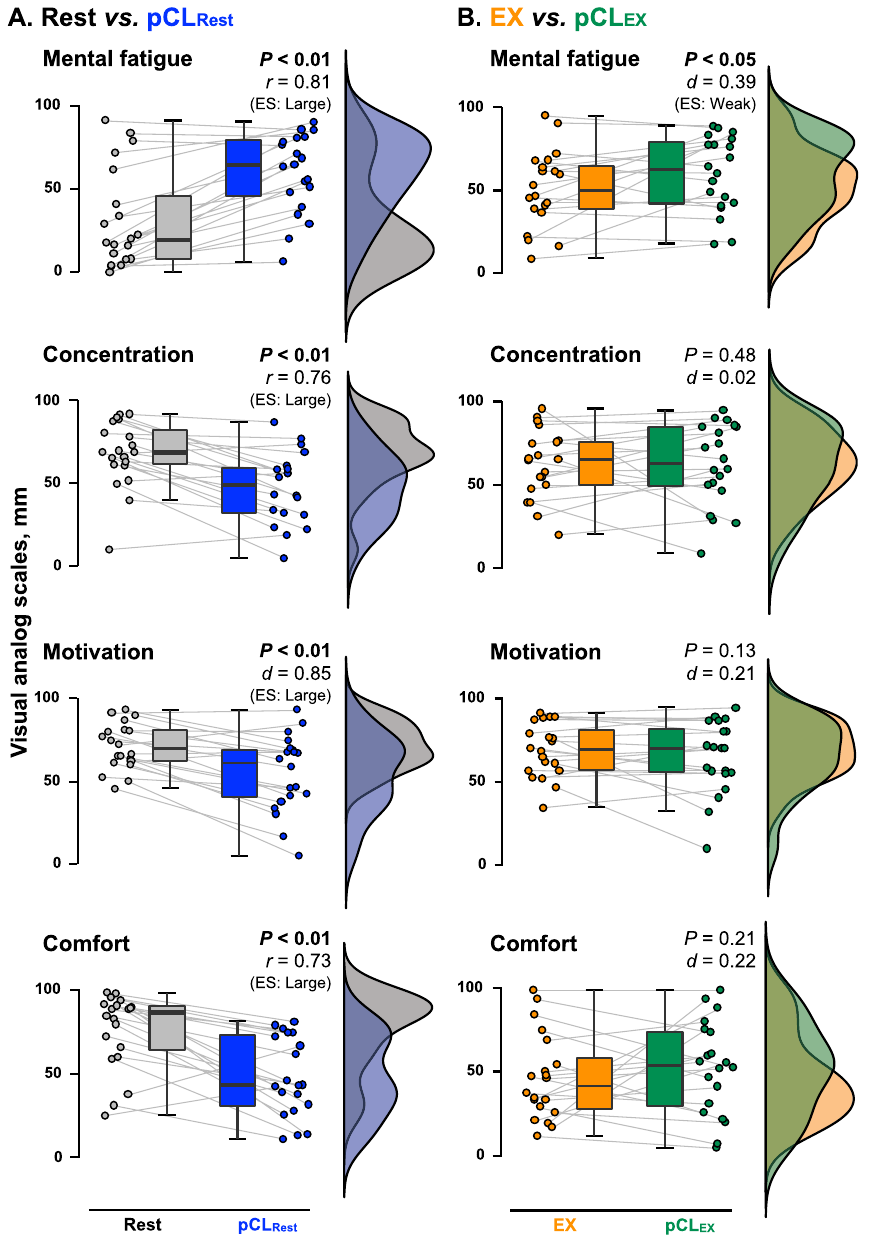
Figure 1. The psychological parameters. ( A ) State mental fatigue, concentration, motivation, and comfort immediately after a 50-min resting period with (pCL Rest ; blue) and without (Rest; gray) prolonged cognitive load (pCL). ( B ) Those psychological parameters immediately after a 50-min exercise period with (pCL EX ; green) and without (EX; orange) pCL. Raincloud plots showing the distribution of each psychological parameters assessing visual analog scale (VAS). Circle plots represent individual data, and box-and-whisker plots are median (IQR and max/min). ES; Effect